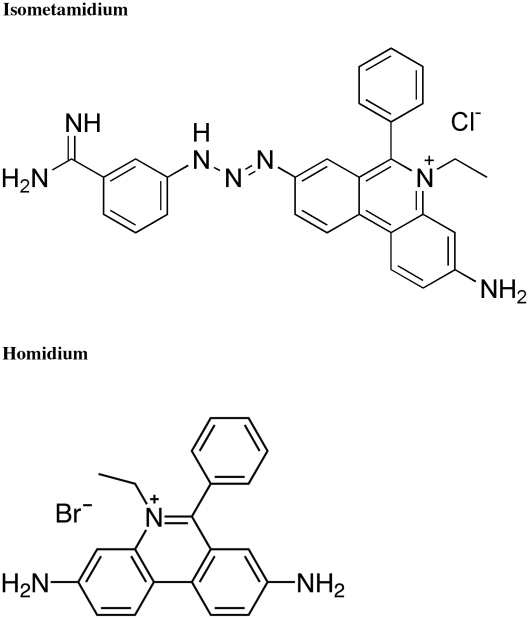
Structural relatedness between isometamidium and ethidium salts.